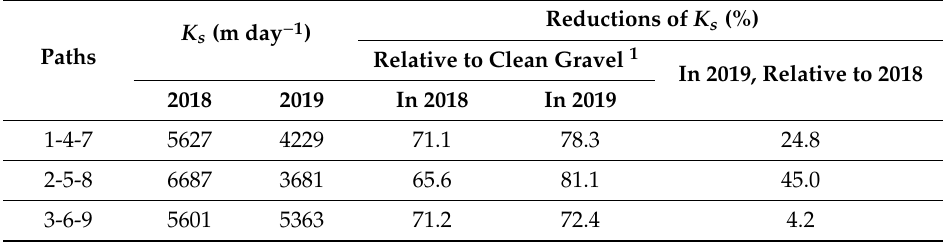
Table 4. Spatial and temporal variation of the K s (m day − 1 ) values along the main paths in 2018 [18] and 2019.